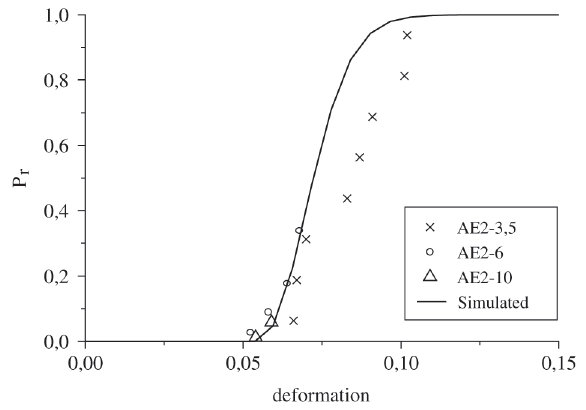
Figure 3. F32-T1: Probability of fracture vs. rupture deformation at the middle section of 2 mm notch specimens, normal and sub- size specimens.